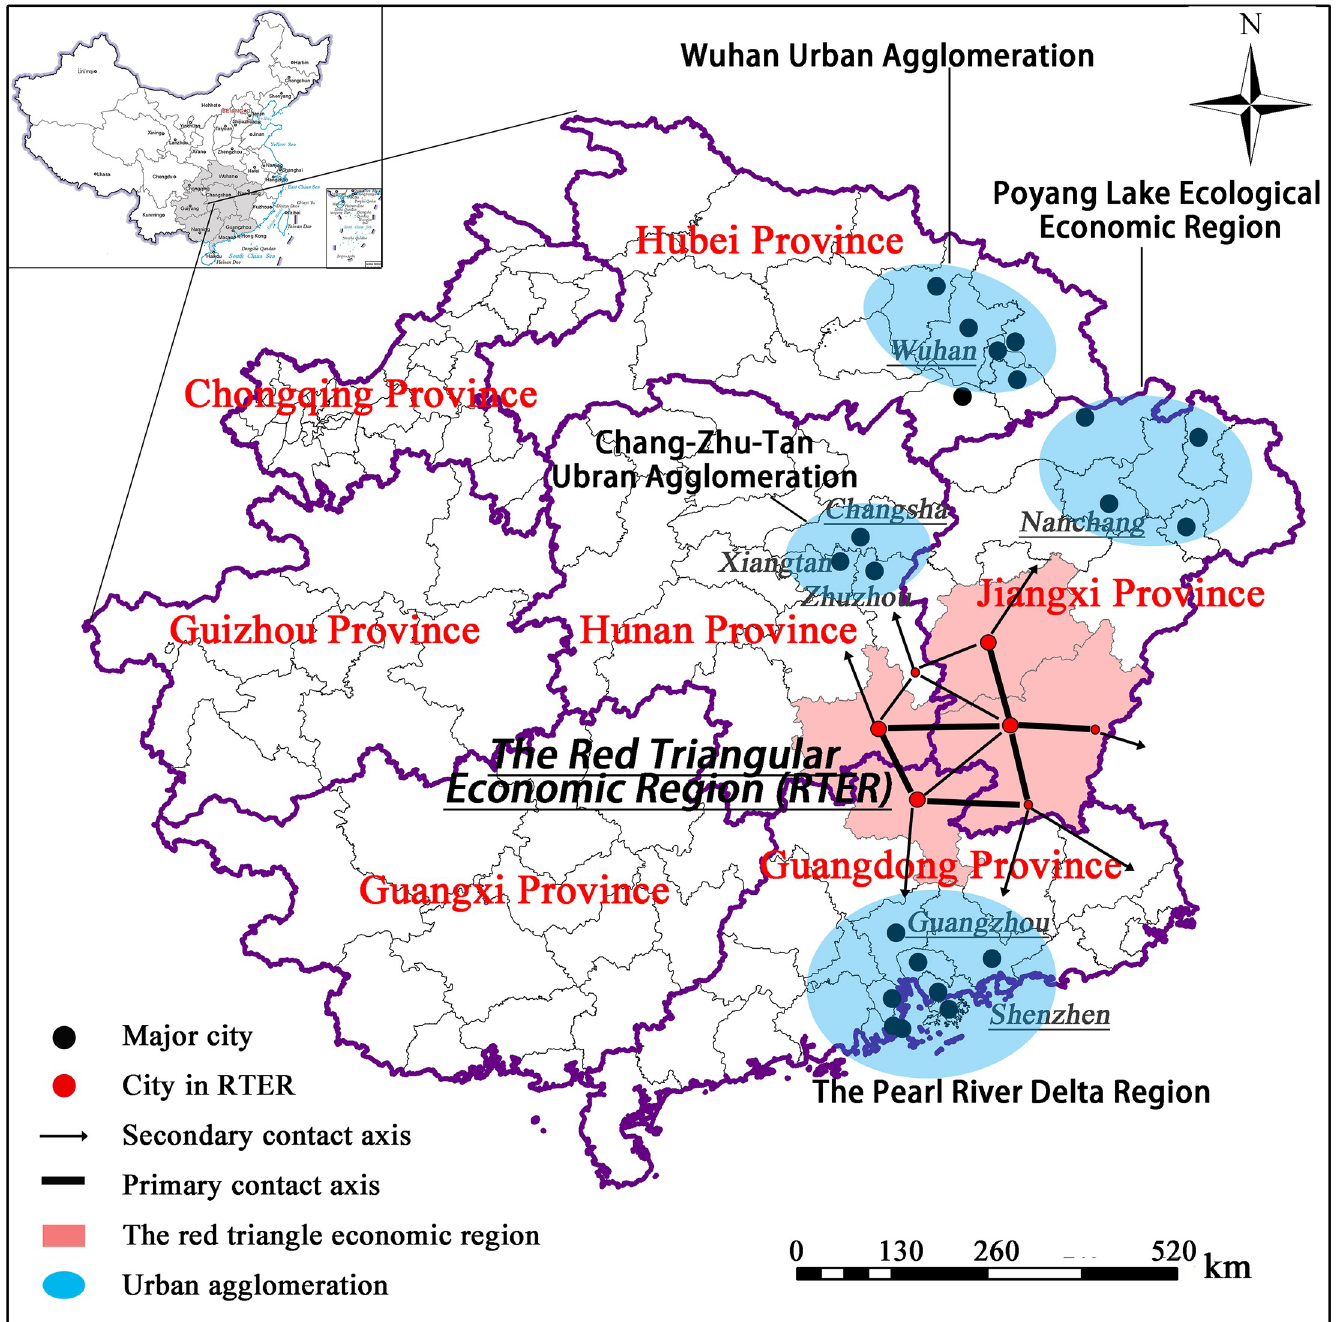
Fig 5. Cross-provincial regional integration and economic contact in RTER. (Reprinted from http://www.ngcc.cn/ngcc/ under a CC BY license, with permission from the National Geomatics Center of China , original copyright 2012).